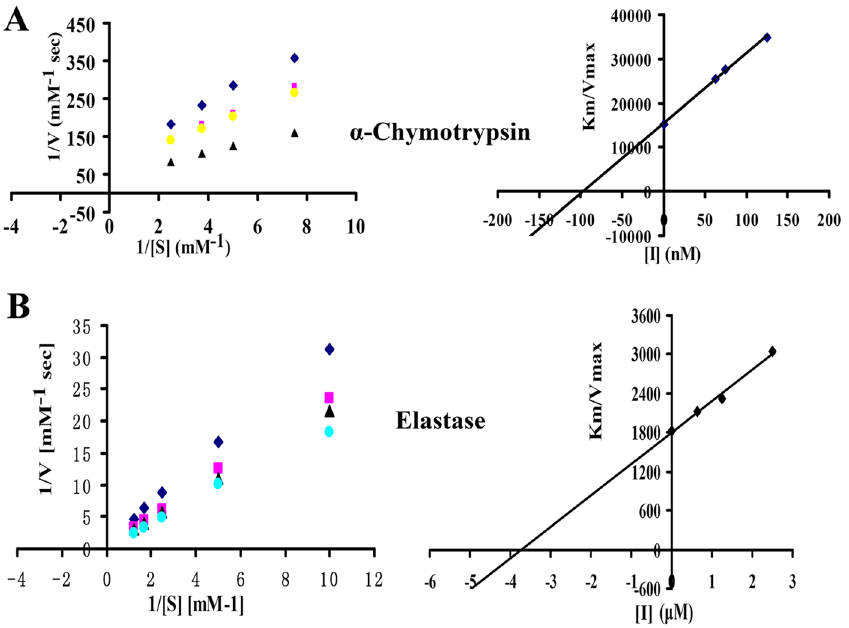
Figure 5. The Ki values of rSjAPI with a -chymotrypsin and elastase. (A) Lineweaver-Burk plots for the determination of Km/Vmax values of a - chymotrypsin activity on a synthetic chromogenic substrate in the absence or presence of 60 nM, 75 nM, and 125 nM rSjAPI, respectively. Secondary plot: the slopes (Km/Vmax) of the primary Lineweaver-Burk graphs were plotted against the inhibitor concentration. The inhibitory constant (Ki) is determined from the intercept point on the x-axis. (B) Lineweaver-Burk plots and secondary plots show the inhibition of elastase by rSjAPI in the absence or presence of 625 nM, 1250 nM, and 2500 nM rSjAPI, respectively. Ki values were showed as the mean 6 standard error at least three experiments.